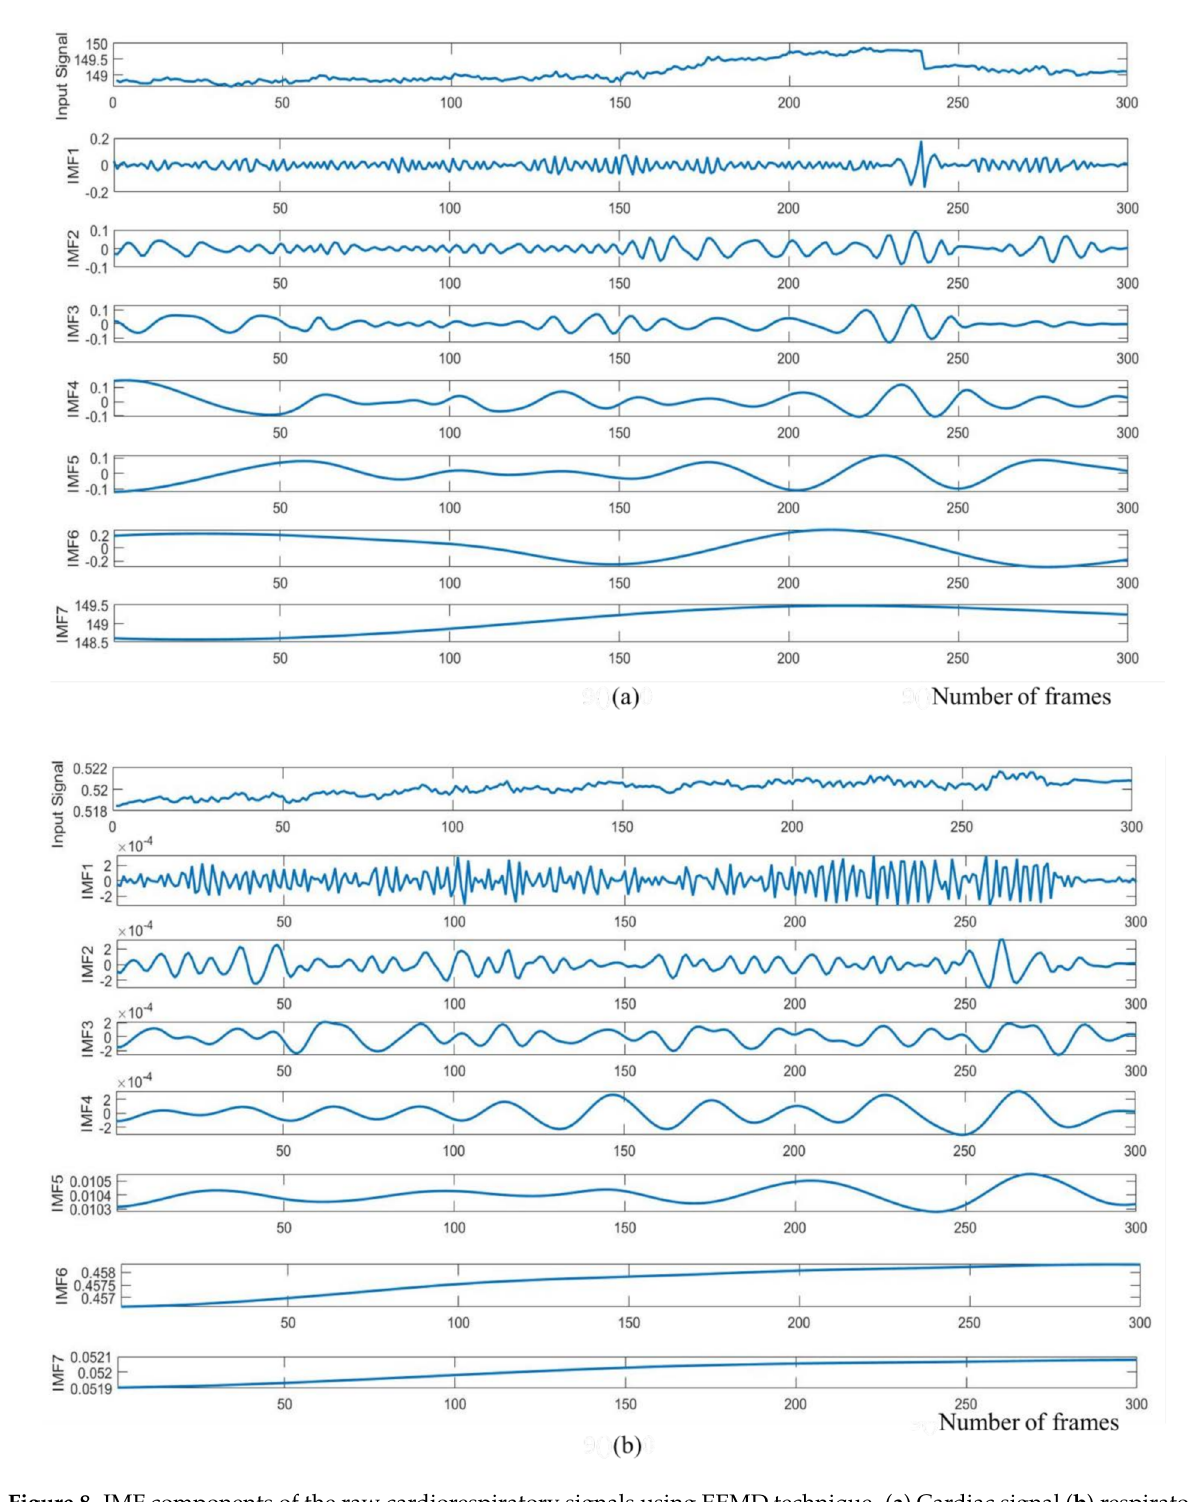
Figure 8. IMF components of the raw cardiorespiratory signals using EEMD technique. ( a ) Cardiac signal ( b ) respiratory